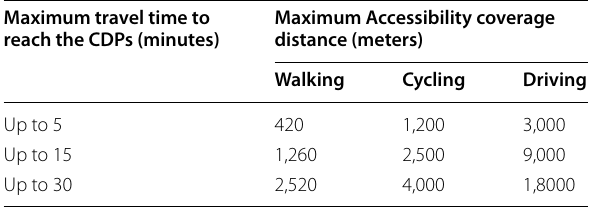
Table 4 Travel time and accessibility coverage distance on foot, cycling, and car